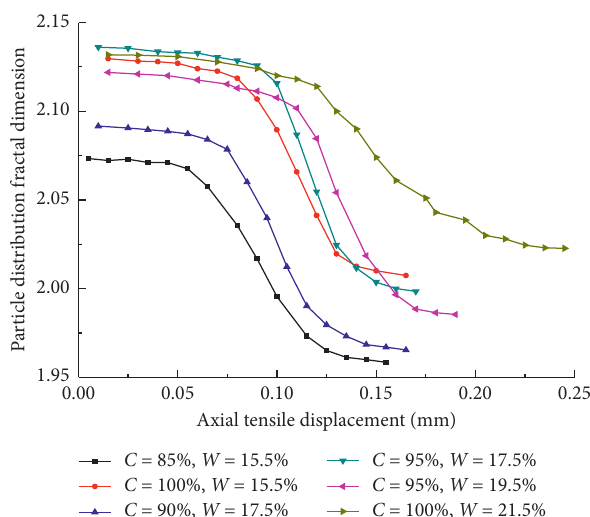
Figure 21: The change of particle distribution fractal dimension in Zone